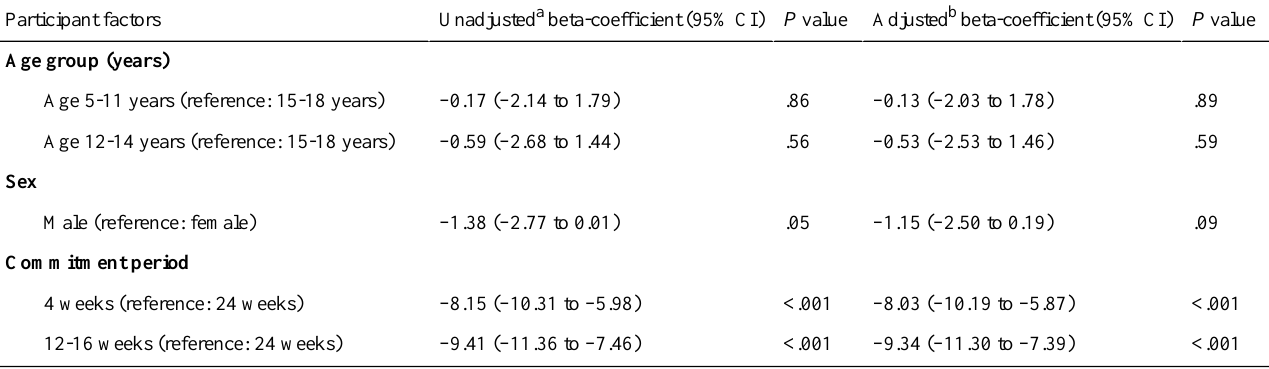
Table 4. Factors associated with total number of coaching sessions, among all participants